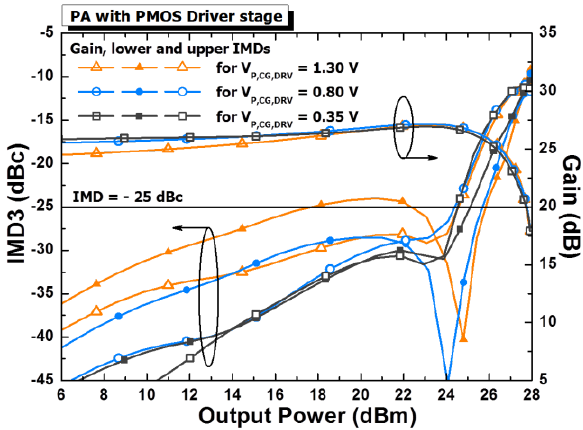
Figure 10. Simulated IMD3 and gain of proposed PMOS stage with various common-gate bias voltage (V DD = 3.3 V and V P,CS,DRV = 2.79 V).